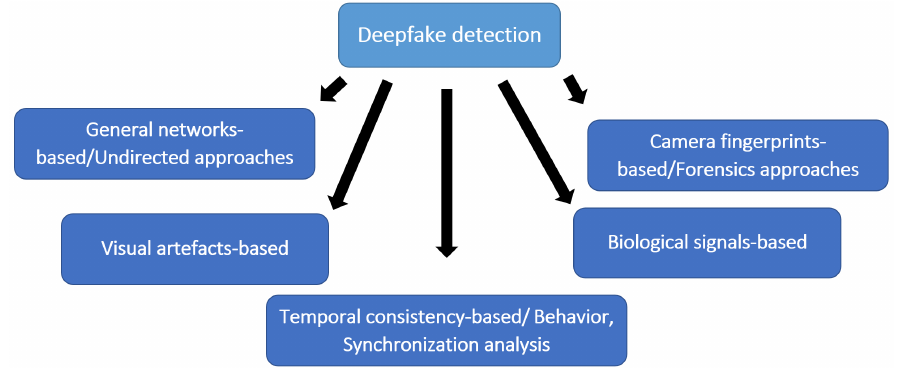
Figure 1. Taxonomy of deepfake-detection